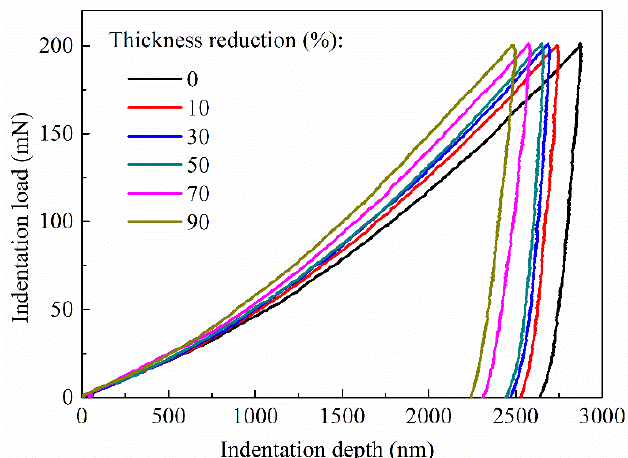
Figure 5. Load–displacement curves for indentations of the as-annealed and cold-rolled AA6061 alloy at a normal load of 200 mN.